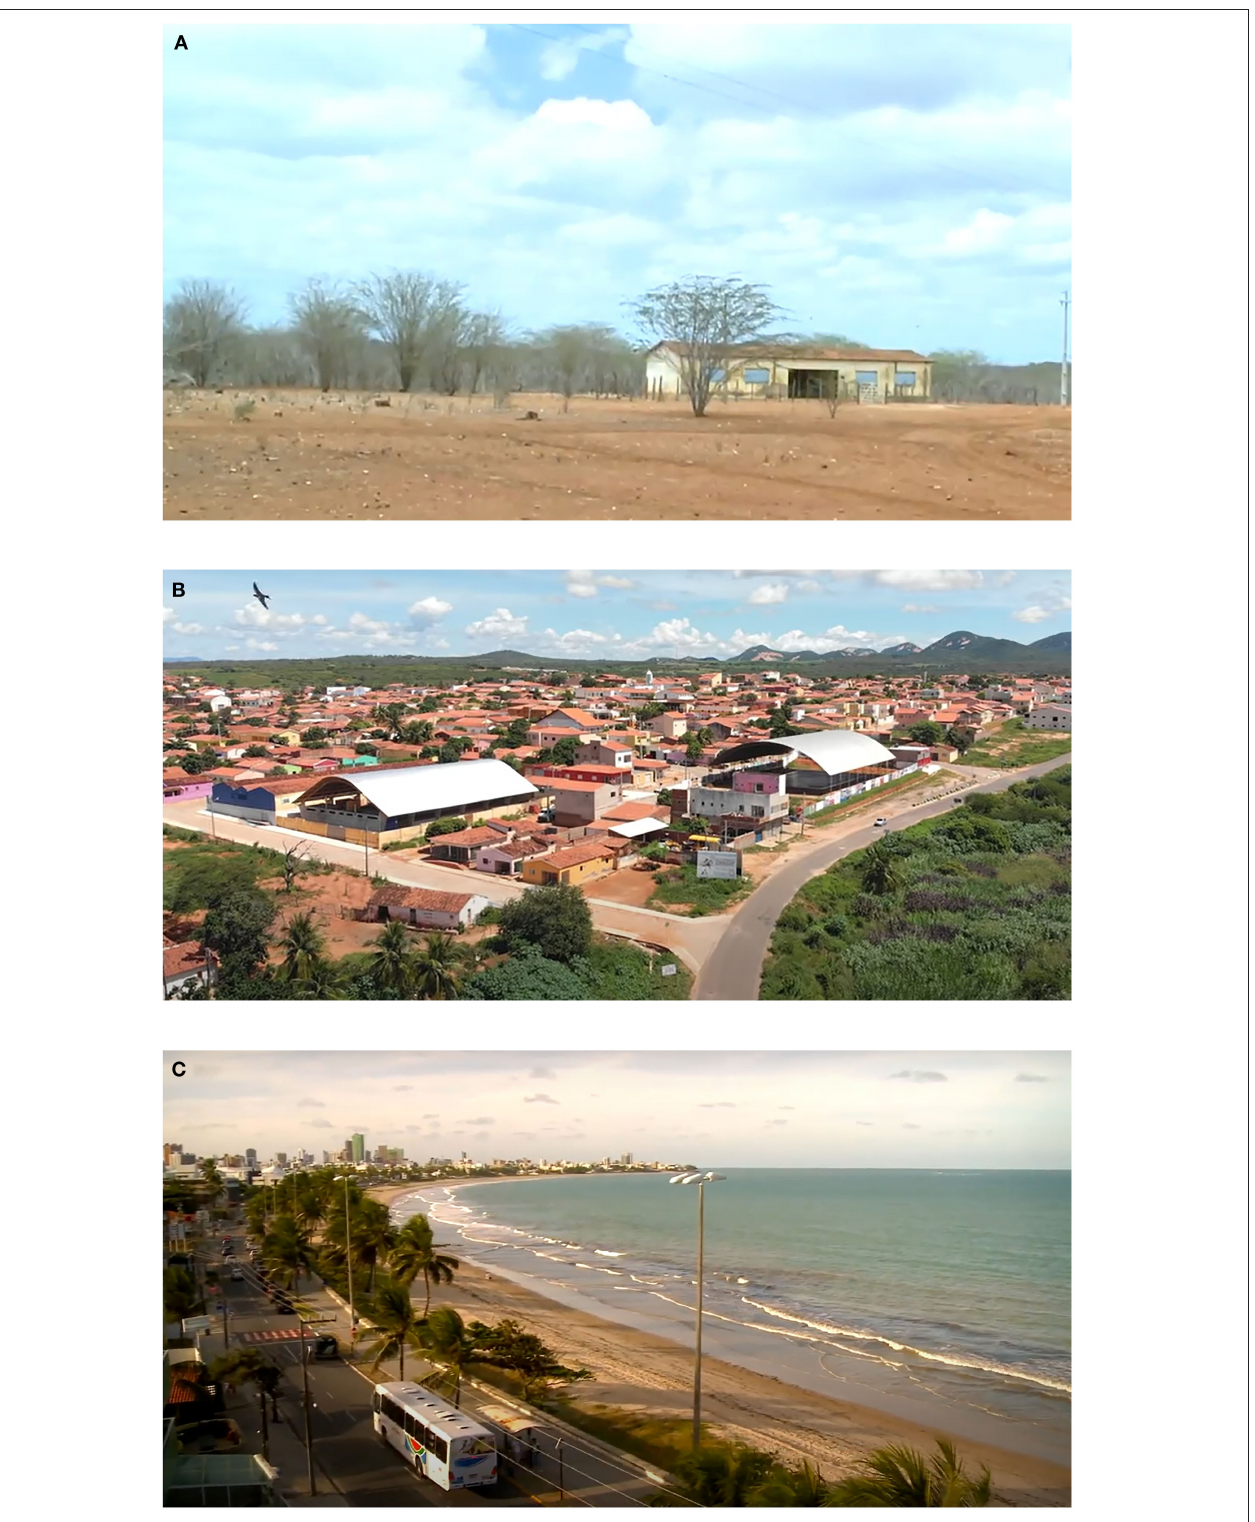
FIGURE 4 | Examples of living conditions of families included in the study. Inland areas vary from (A) isolated households in the drylands to (B) small size cities. (C) The coastal city, which is larger and more afluent.